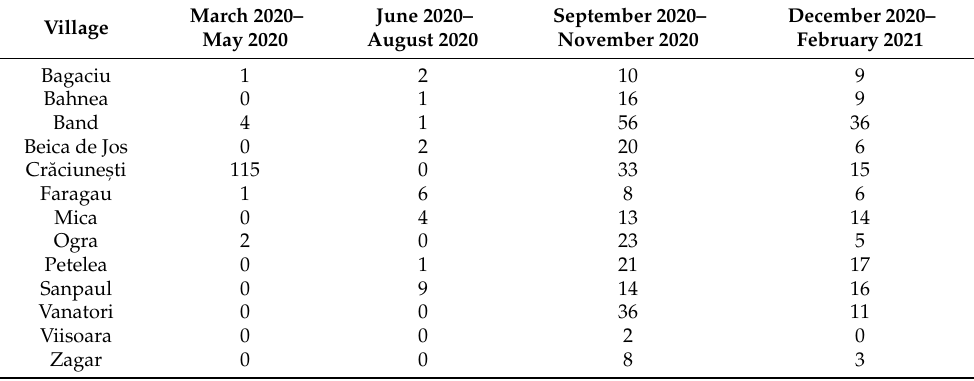
igani community people infected with SAR-COV2 in Mures ,